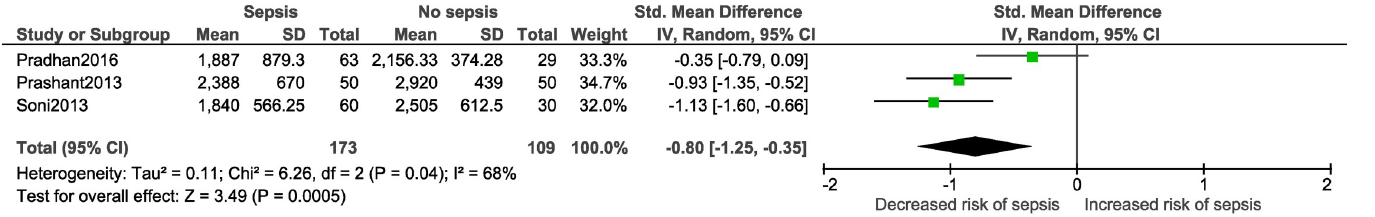
Fig 5. Forest plot showing a random-effects meta-analysis of standardized mean difference of birth weight of neonates with and without sepsis.